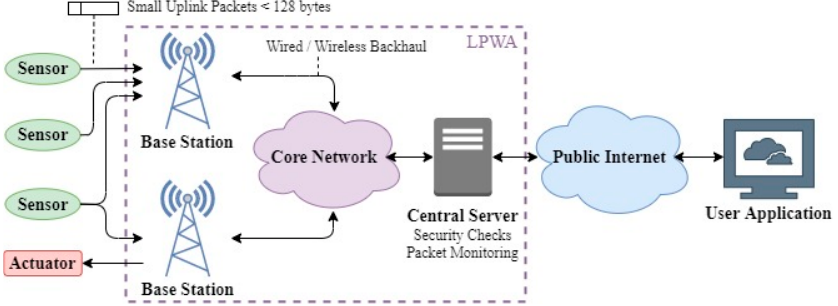
Figure 3. General network architecture diagram of LPWA networks.